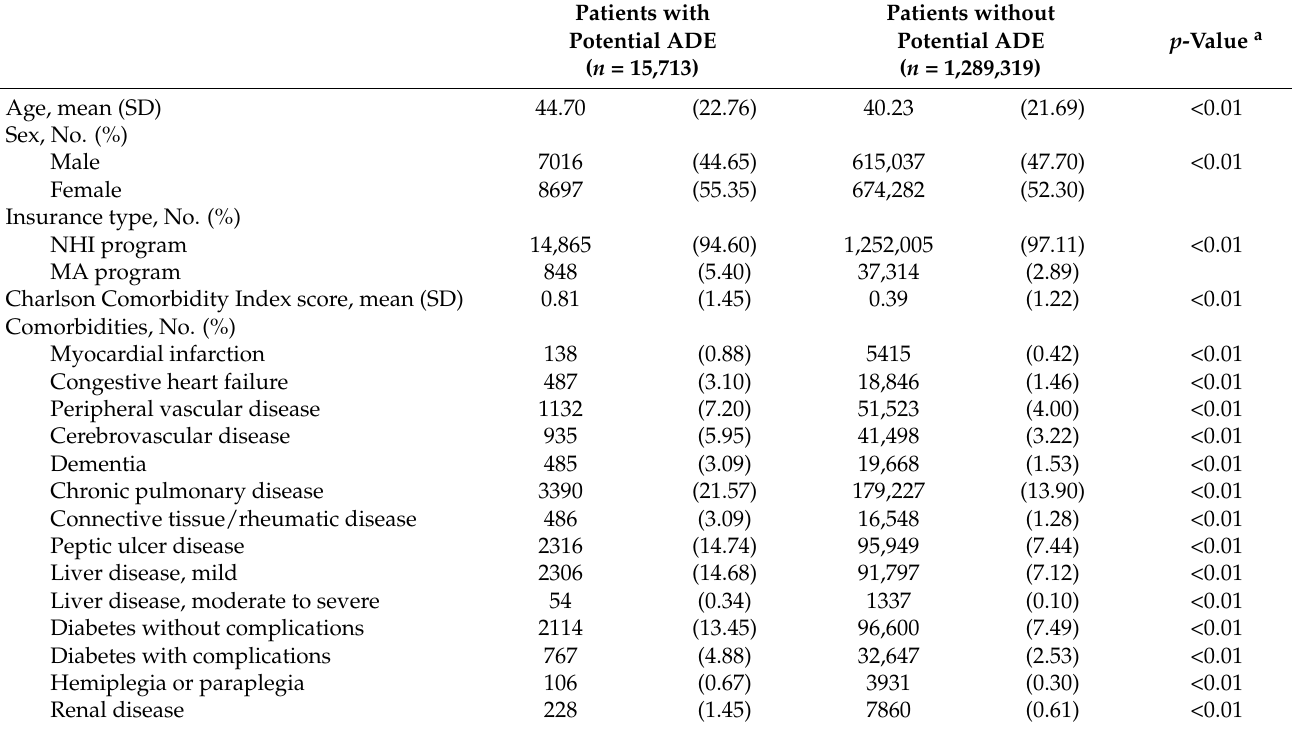
Table 1. Baseline characteristics of the study population. Patients